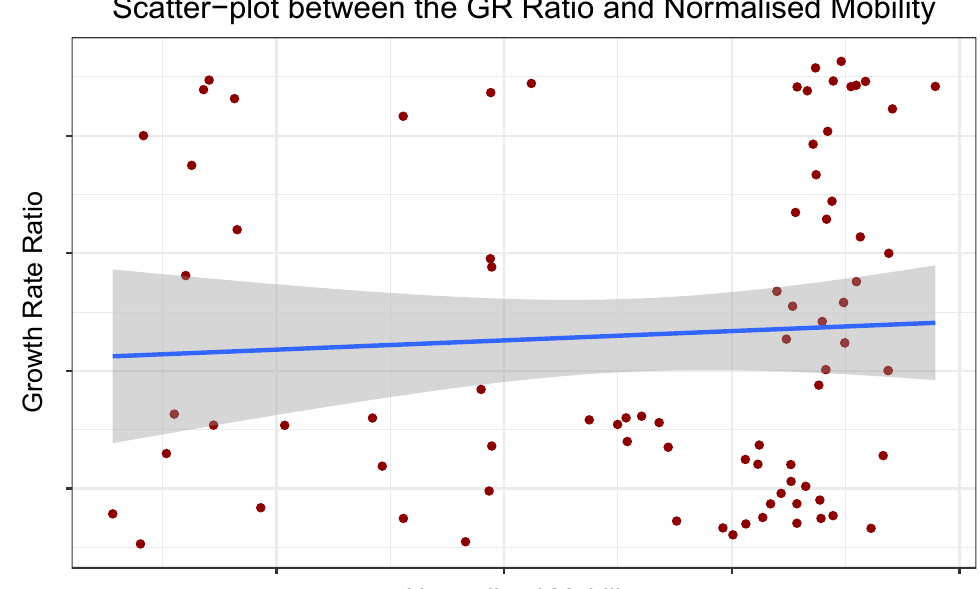
Figure 16. Scatterplot growth-rate ratio and normalised